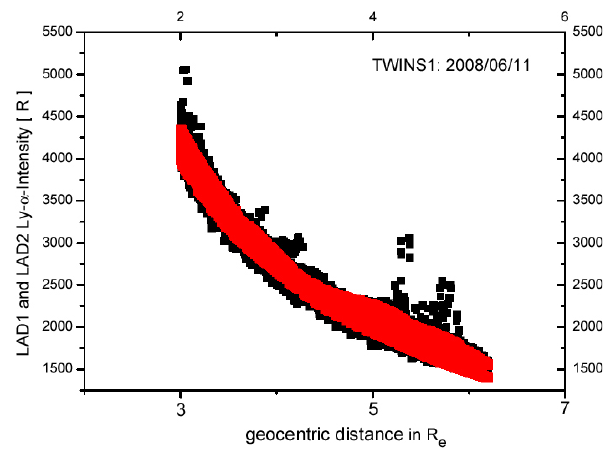
Fig. 8. Day-/nightside normalized H-density ratio (at the equator) as fitted with the 3-D H-density model (black) for 11 June 2008 and compared with the solstice-model (10.7cm radioflux = 80) by Hodges (1994) (blue). H-densities on both sides were normalized to corresponding reference density values at 3 R E